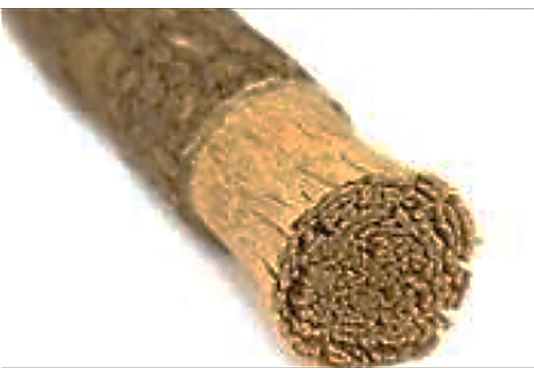
Figure 3: Frayed miswak